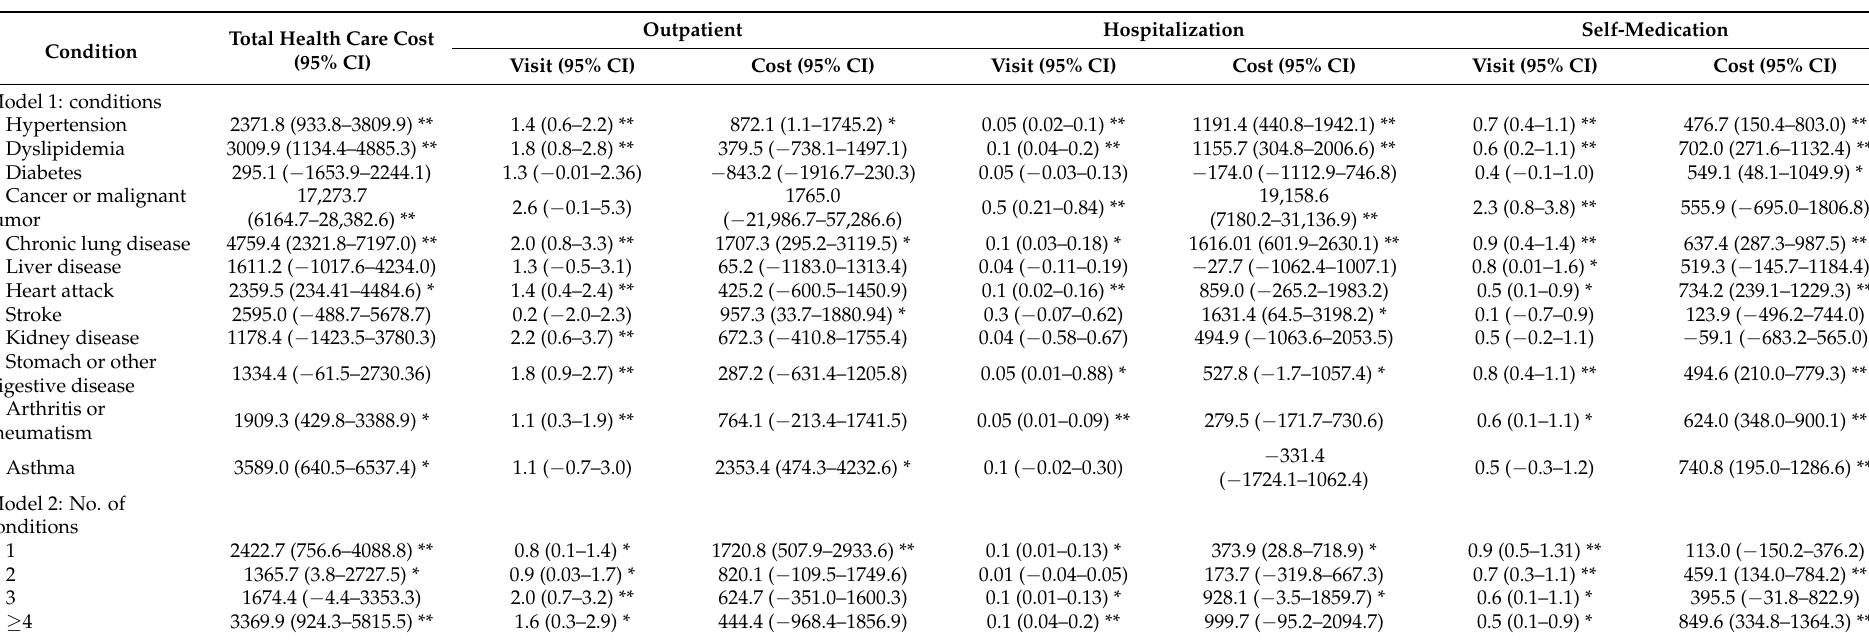
Table 2. Additional health care use and cost among chronic patients with depressive symptoms compared with chronic patients without depressive